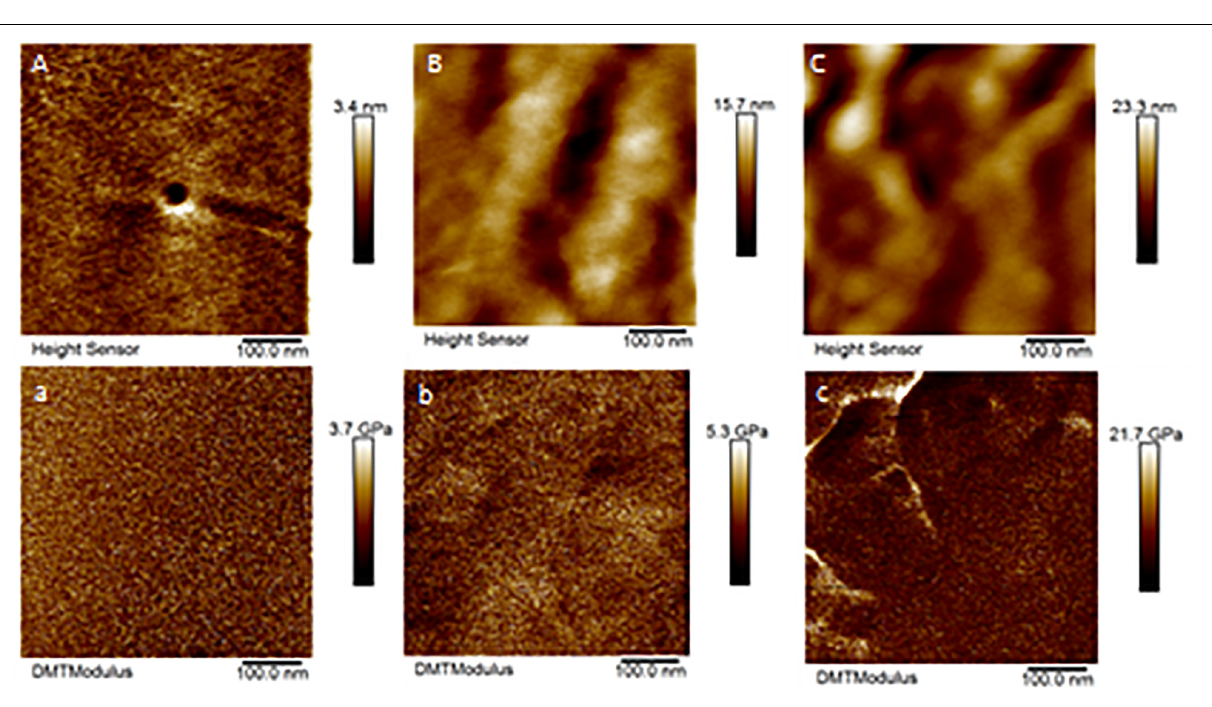
FIGURE 3 | AFM-QNM images of the cement cone obtained from a naturally fed tick. (A,a) , (B,b) , (C,c) are the height and modulus images of the section 1, 2, and 3 of the cement cones, respectively. An average modulus of 2.9, 4.6, 7.1 GPa was obtained for the section 1, 2, and 3,